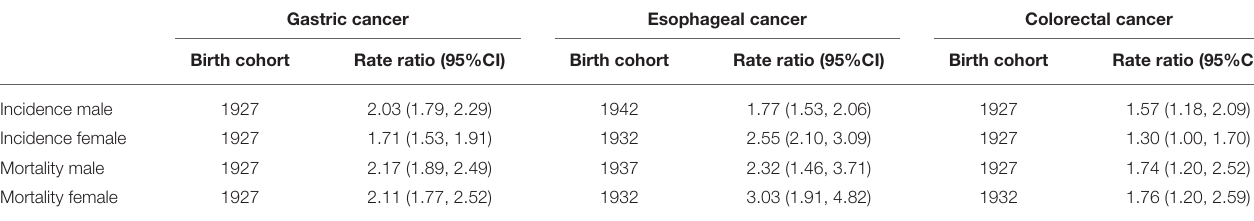
TABLE 4 | Highest cohort effects (Rate ratio) on GI cancers incidence and mortality rates and the corresponding birth